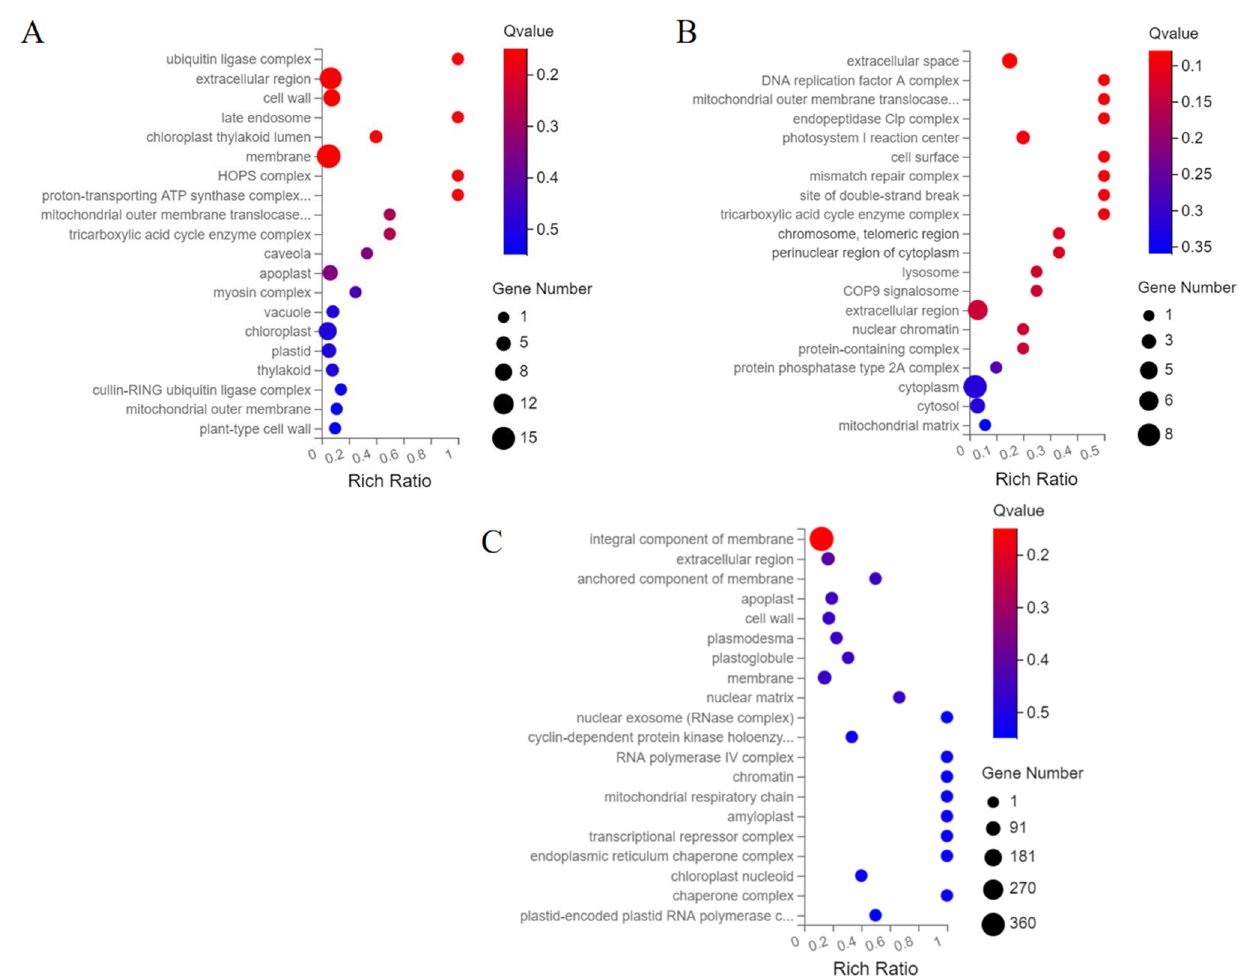
Figure 4. GO functional enrichment of differentially expressed genes in tomato inflorescences. ( A ): E_SR ‐ vs. ‐ E_CI functional enrichment bubble diagram. ( B ): M_SR ‐ vs. ‐ M_CI functional enrichment bubble diagram. ( C ): L_SR ‐ vs. ‐ L_CI functional enrichment bubble diagram. The size of the bubble indicates the number of genes enriched in the GO term. The color of the bubbles indicates the Q value. The enrichment factor is the ratio of the number of differentially expressed genes annotated in the pathway to the number of all genes annotated in the pathway. The higher the enrichment factor is, the higher the enrichment degree of the pathway.